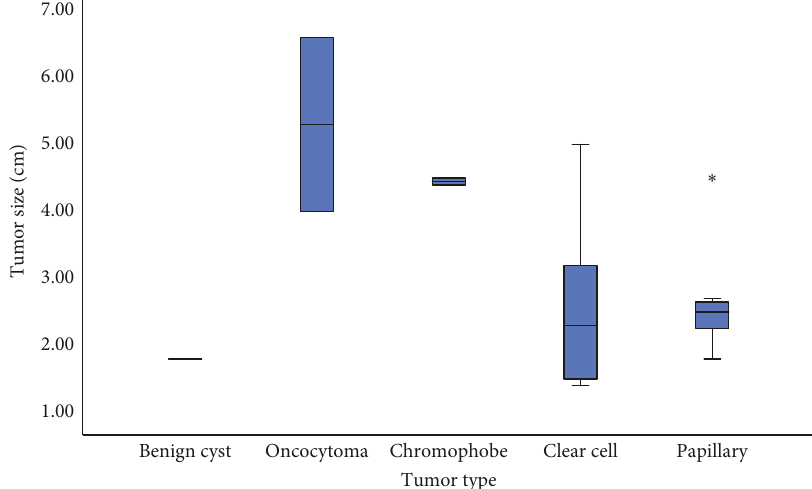
Figure 2: Box and whisker plot of renal mass size compared to the renal tumor subtype for trend.